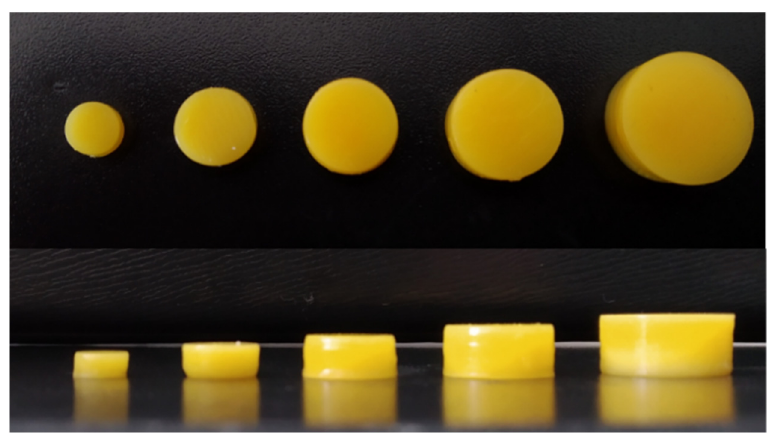
Table 8. Parameters characterizing the designed and printed tablets ( n = 3).